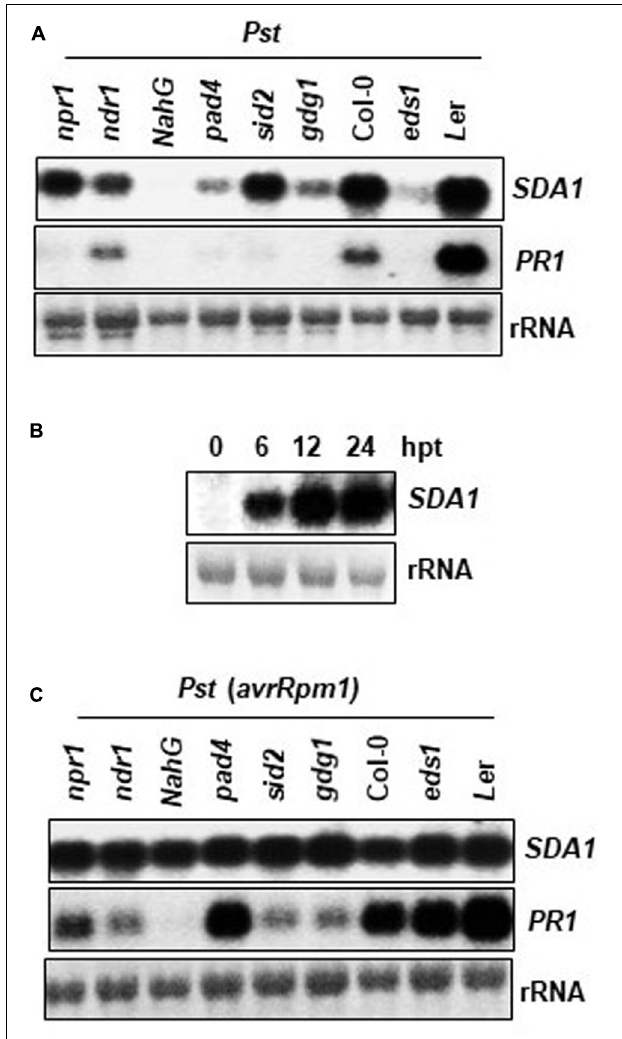
FIGURE 3 | Expression analysis of SDA1 in defense mutants and in response to SA. (A,C) Mutant and wild type plants (4-week-old) were treated with Pst DC3000 (A) and Pst DC3000 (avrRpm1) (C) at a concentration of 5 × 10 7 cfu/mL and tissue samples were harvested at 24 hpi (hours post-inoculation). Northern gel blot analysis was employed to determine transcript levels. Blots were stained with methylene blue to show the relative amounts of RNA in each lane (rRNA). Blots were probed with SDA1 gene probe, stripped and re-probed with PR1 gene probe. All mutants are in the Col-0 background, except eds1 , which is in the Ler background. (B) Four-week-old wild-type (Col-0) plants were sprayed with 1 mM SA. Rosette leaves were collected at the indicated hours post-treatment (hpt) for RNA isolation. Transcript levels were determined by RNA gel-blot analysis. Blots were stained with methylene blue to show the relative amounts of RNA in each lane (28S rRNA). Blots were probed with the SDA1 gene probe. All experiments were repeated at least twice and similar results were obtained. Pst , Pst DC3000; Pst ( avrRpm1 ), Pst DC3000 ( avrRpm1 ).